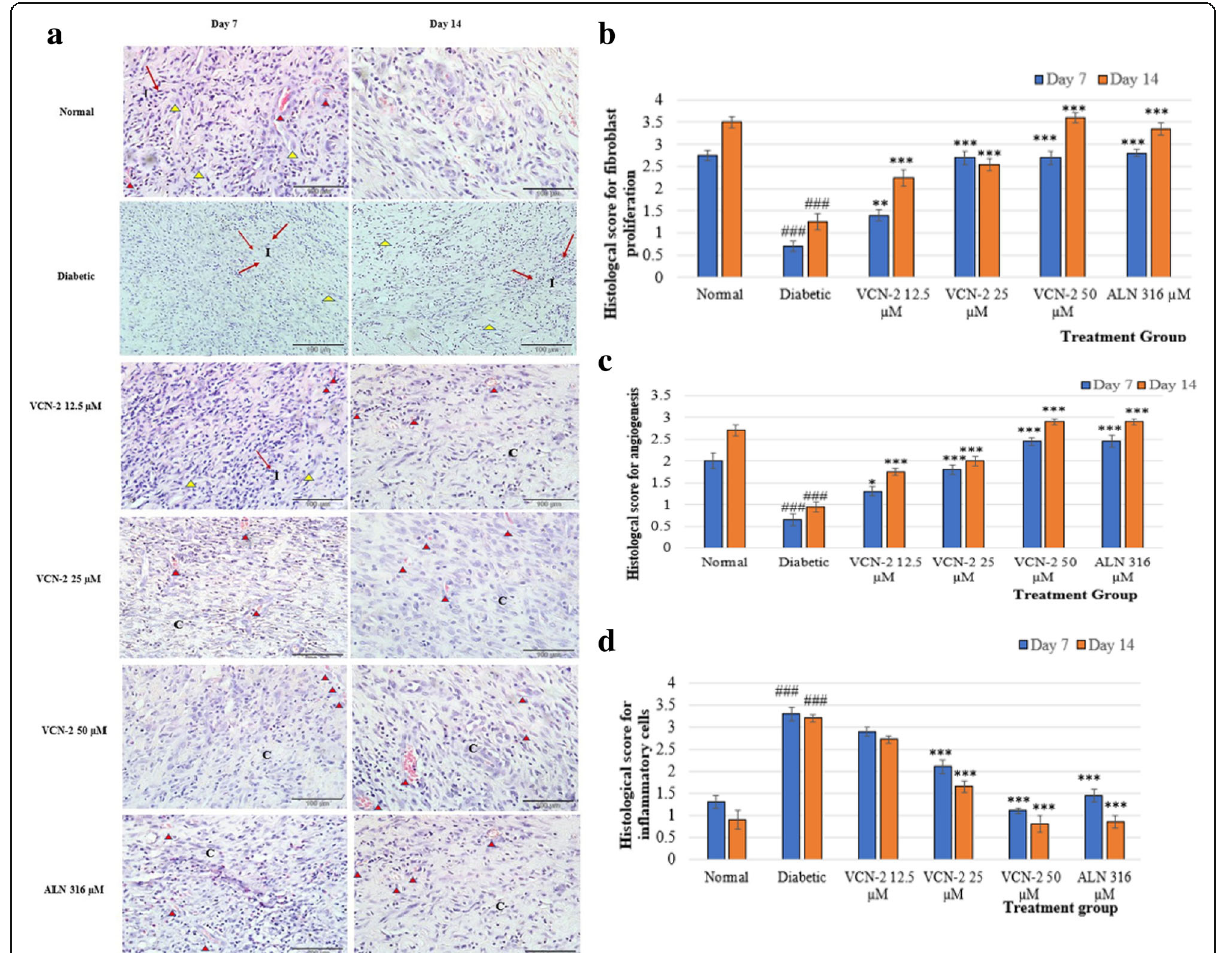
Fig. 3 a Normal rat and diabetic rat treated with blank, VCN-2 and allantoin dressing on day 7 and 14. Diabetic rats treated with VCN-2 showed more neovascularization on day 14 compared to day 7. Wound of rat on day 14 contained more blood vessels and showed well connective tissue deposition, n = 6, 400x with H&E staining. Abbreviations: (I): Inflammatory cell and (C): Connective tissue. Representation : angiogenesis and : fibroblast cell. b Histological finding score of fibroblast proliferation; ( c ) angiogenesis and ( d ) inflammatory cells infiltrate (score from 0 to 4) from 10 randomly chosen high-power fields (× 400) from three sections in wound treated with difference films on day 7 and 14. Data are means ± SEM histological score ( n =6). ### p <0.001, diabetes versus normal; * p <0.05, ** p <0.01 and *** p <0.001, treatment groups versus